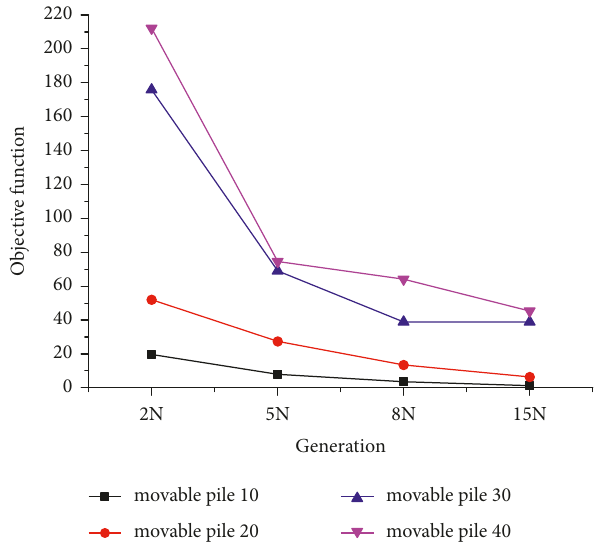
Figure 9: The influence of the genetic generation on the objective function for a fixed pile